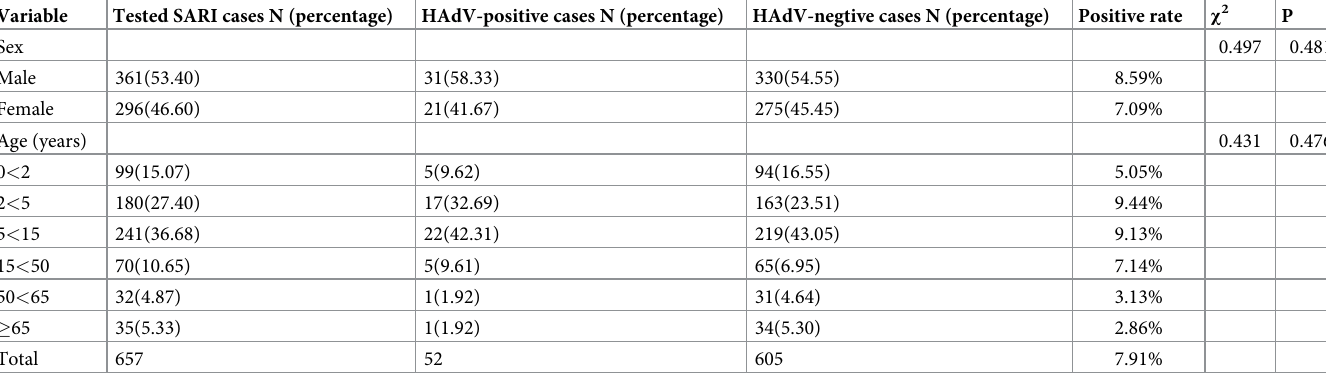
Table 2. HAdV-positive in hospitalized patients of different ages and gender with SARI. Variable Tested SARI cases N